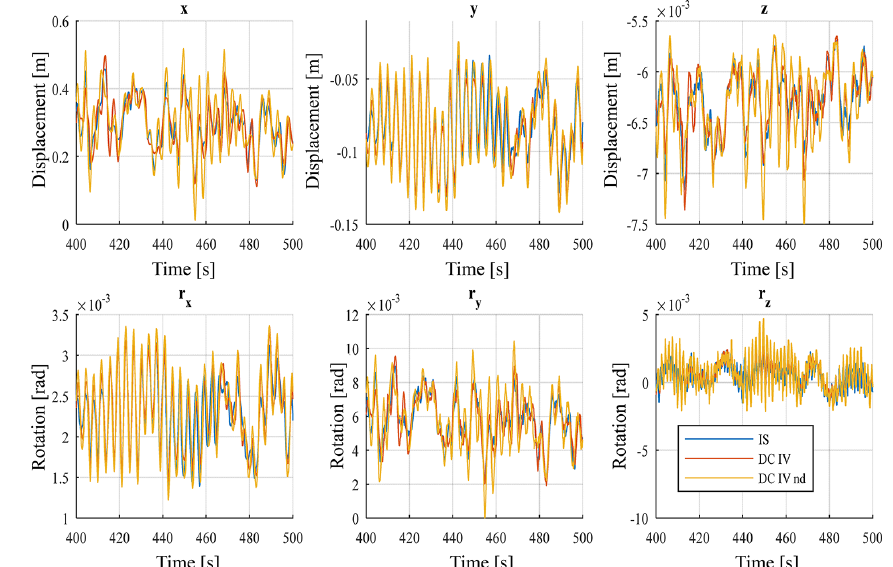
Figure 18. Time-history response for tower top displacements of DC IV with a wind speed of 20ms − 1 . The yellow curve (DC IV nd) shows the time-history response for a decoupled model with full rotor loads and no damper (nd)